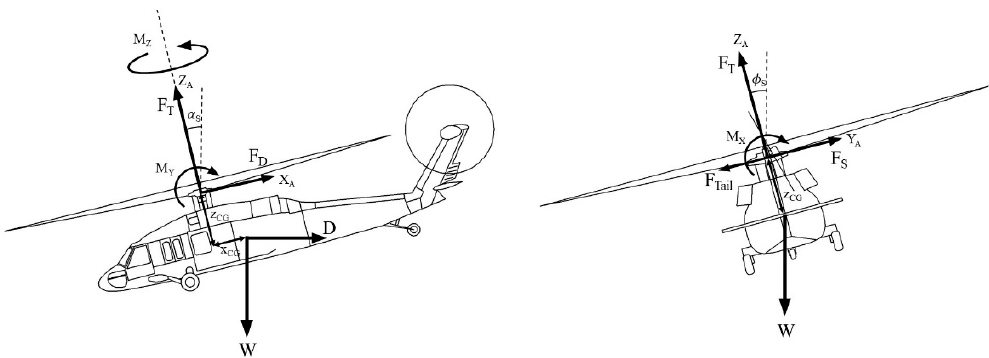
Figure 3. Forces and moments for the trim solution.